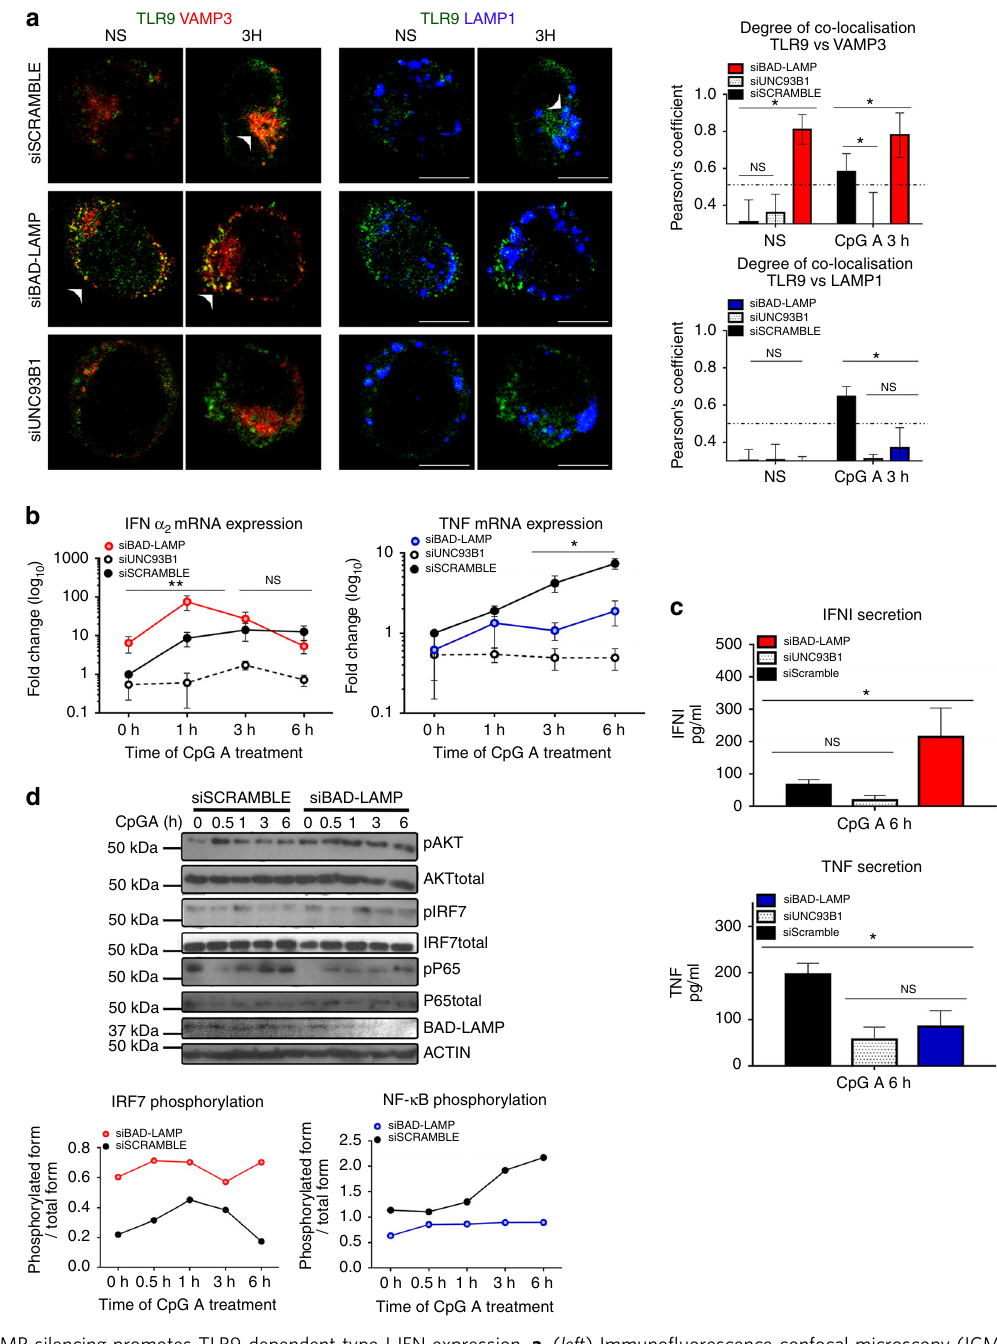
Fig. 6 BAD-LAMP silencing promotes TLR9-dependent type-I IFN expression. a . ( left ) Immuno fl uorescence confocal microscopy (ICM) on CAL-1 electroporated with the different indicated siRNA and stimulated with CpG-A for indicated times. Analyse at steady state (NS) or 3 h after CpG-A stimulation of LAMP1, VAMP3 and TLR9 distribution. Images are representative of at least three independent experiments. Arrowheads indicate co-localisation areas. Scale bars = 5 μ M. ( right ) Quanti fi cation of co-localisation between TLR9 with VAMP3 ( top ), or with LAMP1 ( bottom ) at steady state (NS) or 3 h after CpG-A stimulation, was performed by Pearson ’ s coef fi cient measurement using ImageJ. Graphic represent Pearson ’ s coef fi cient means of 50 different cells ± s.d. from at least three independent experiments. b IFN α 2 ( left ) and TNF ( right ) mRNA level were monitored by RT-QPCR. Raw data have been normalised to housekeeping gene (GAPDH) and graphics represent fold change ± s.d. compared to non-stimulated cells from three independent experiments minimum. c IFN α ( top ) and TNF ( bottom ) secretion were monitored by ELISA at 6 h after CpG-A stimulation. Graphics represent cytokines concentration ± s.d. from three independent experiments minimum. d ( left ) CAL-1 cells electroporated with siRNA scramble or siRNA BAD-LAMP were treated with CpG-A for indicated times prior lysis and SDS PAGE treatment. Expression of BAD-LAMP, AKT, IRF7, p65 NF- κ B subunit and their phosphorylated forms were detected by immunoblot. β -actin is shown as loading control. ( right ) Quanti fi cation of IRF7 ( top ) and p65 ( bottom ) phosphorylation levels normalised to their total form by ImageJ quanti fi cation. * P < 0.05 by unpaired student ’ s t -test